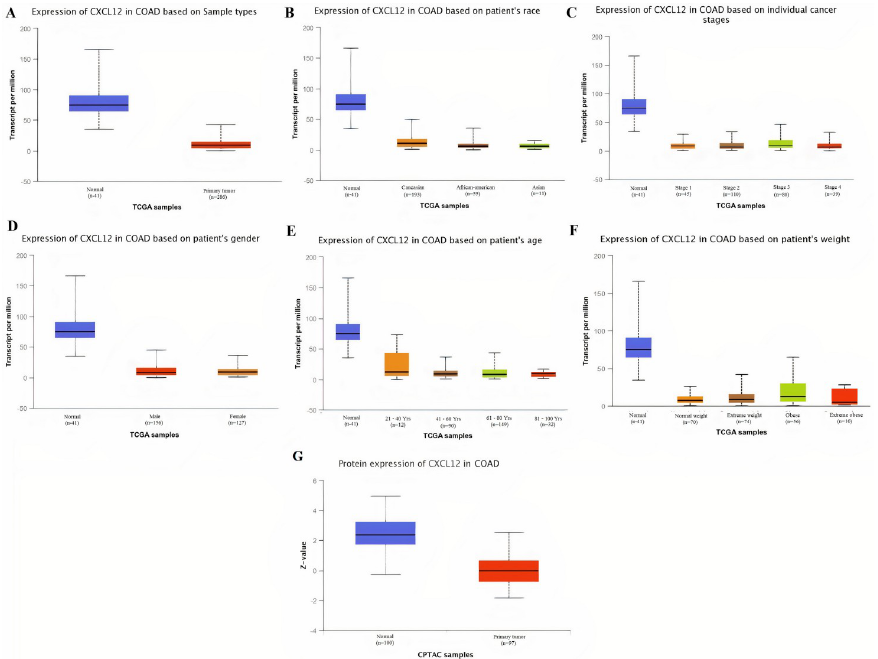
Fig 5. Box plots showing the relative expression levels of CXCL12 in normal and COAD samples of different clinicopathological features via UALCAN database. Relative mRNA expression of CXCL12: (A) in normal individuals and COAD patients; (B) in normal individuals and COAD patients of different races; (C) in normal individuals and COAD patients of different cancer stages; (D) in normal individuals and COAD patients of different genders; (E) in normal individuals and COAD patients of different age groups; and, (F) in normal individuals and COAD patients of different body weights; (G) Relative protein expression of CXCL12 in normal individuals and COAD patients. A p-value of < 0.05 was considered significant. Normal weight = BMI greater than or equal to 18.5 and BMI less than 25, Extereme weight = BMI greater than or equal to 25 and BMI less than 30, Obese = BMI greater than or equal to 30 and BMI less than 40, and Extreme Obese = BMI greater than